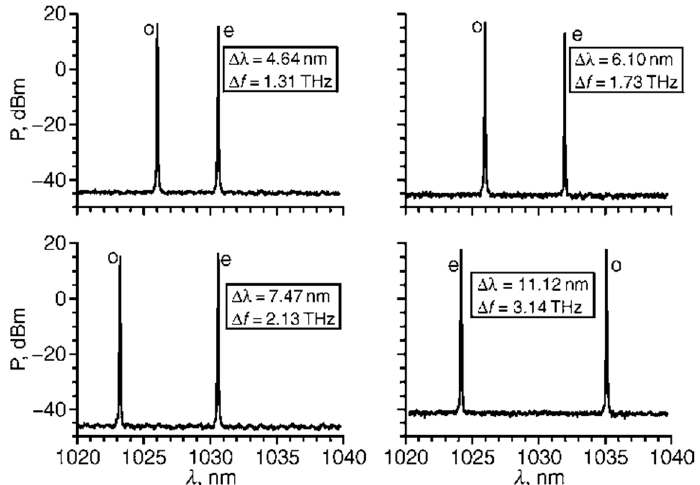
Figure 24. Measured optical spectra of dual-frequency laser when tuned for various frequency dif- ferences [32] .